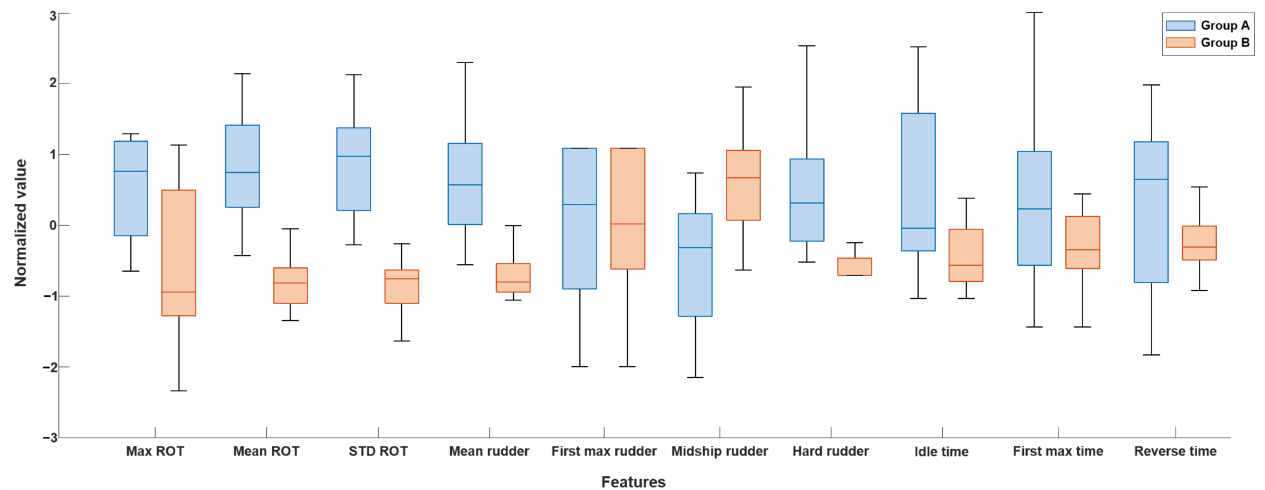
Figure 4. Maneuvering features and